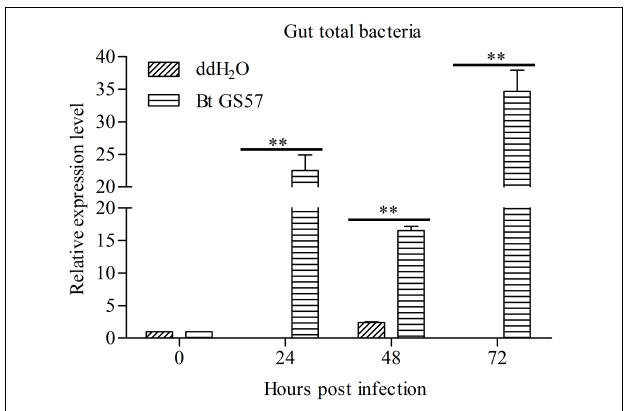
FIGURE 4 | Effects of Bt GS57 infection on the gut bacterial load of Spodoptera exigua . The qPCR-based quantification of gut bacterial load in ddH 2 O and Bt GS57 treatment group of S. exigua ( n = 6) at 0, 24, 48, and 72 h. Gene expression of each sample was normalized to that of S. exigua at time 0 (taken as 1). Data are representative of three independent experiments (mean + s.e.m.). The double asterisk indicates the significant difference determined by the student’s t -test, P < 0.01.